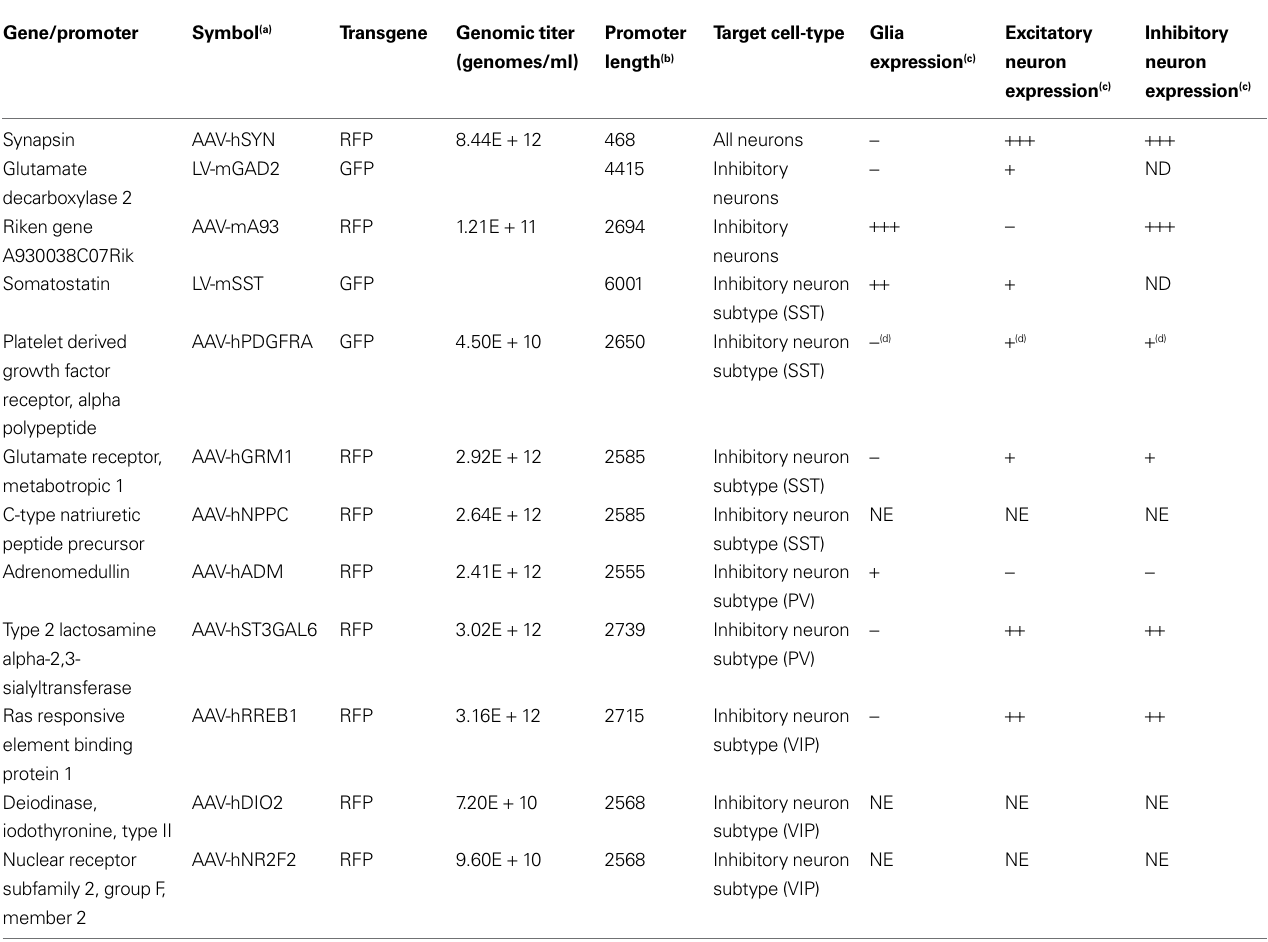
Table 2 | AAV and LV vectors with mammalian promoters.